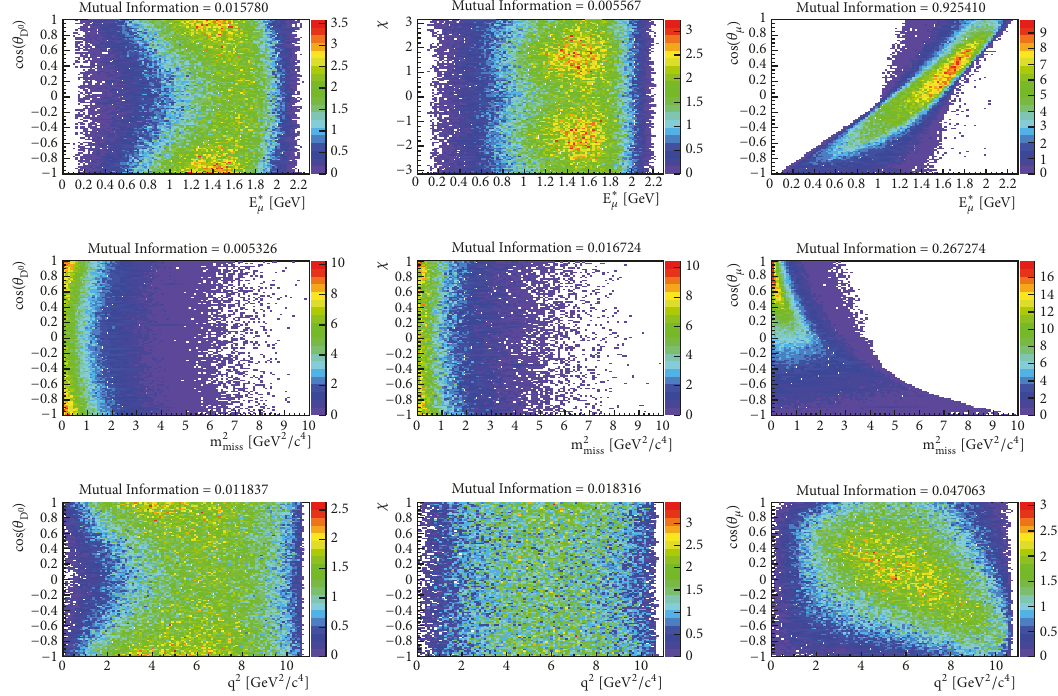
Figure 10: Mutual information between angular and discriminating variables, for 𝐵 󳨀→ 𝐷 ∗+ 𝜇 − ] 𝜇